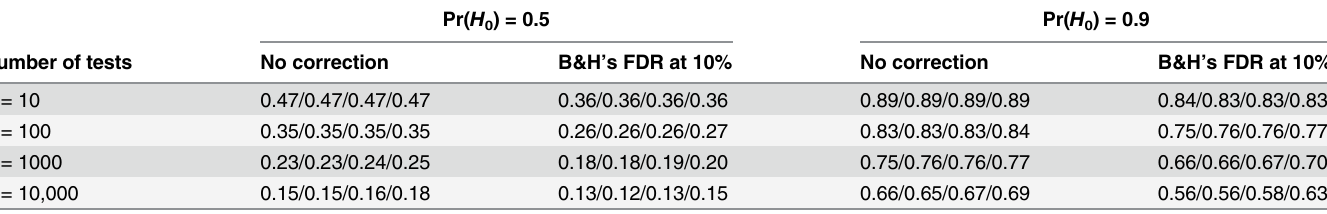
Table 3. The average of posterior probabilities among the 5 smallest P-values, i.e., the false discovery rate (FDR) among the 5 smallest P-values. Table entries W/X/Y/Z give the true probability (W), followed by the estimated probabilities using the integration method (X); the discretization method (Y); the distribution mean method (Z). Sample sizes ( n 1 , n 2 : number of cases, controls in allele counts): n 1 + n 2 =